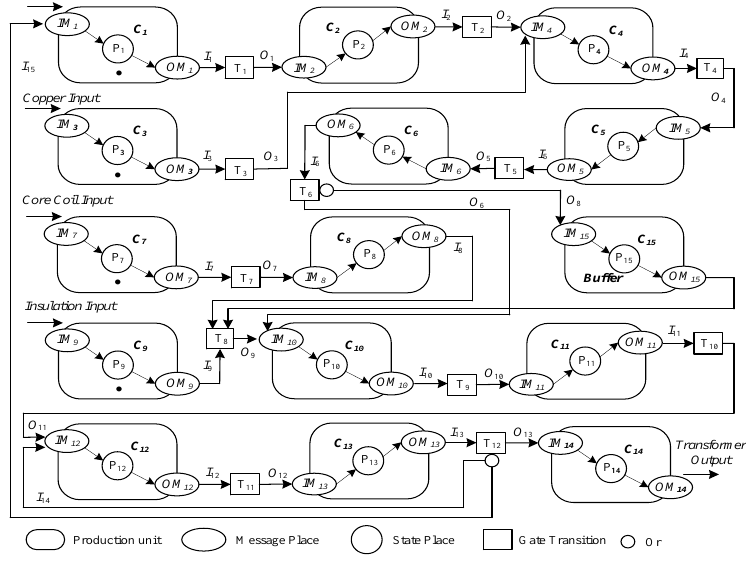
Fig.7. Abstract model of transformer production with